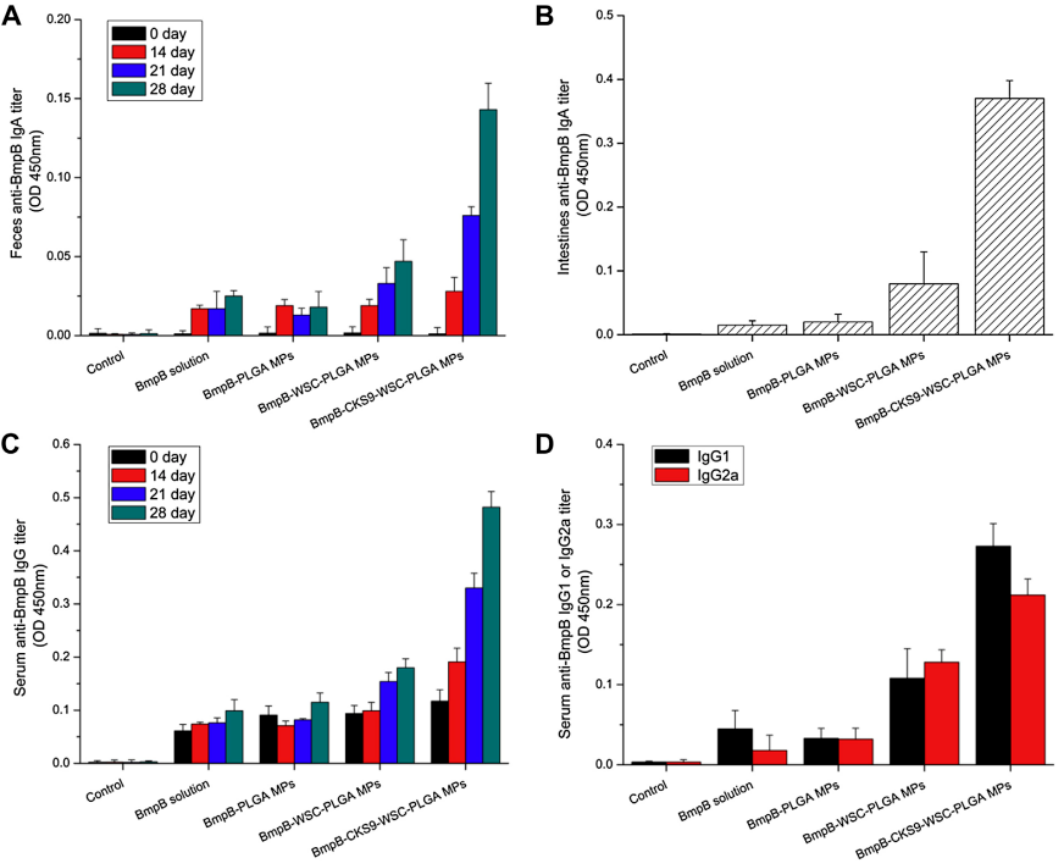
Figure 7. BmpB-specific immune response detection by ELISA after oral administration. Anti-BmpB IgA levels in feces ( A ) and intestine ( B ), anti-BmpB IgG levels in serum ( C ) and anti-BmpB IgG1 and IgG2a ( D ) levels. (Reprinted with permission from Ref. [131]).